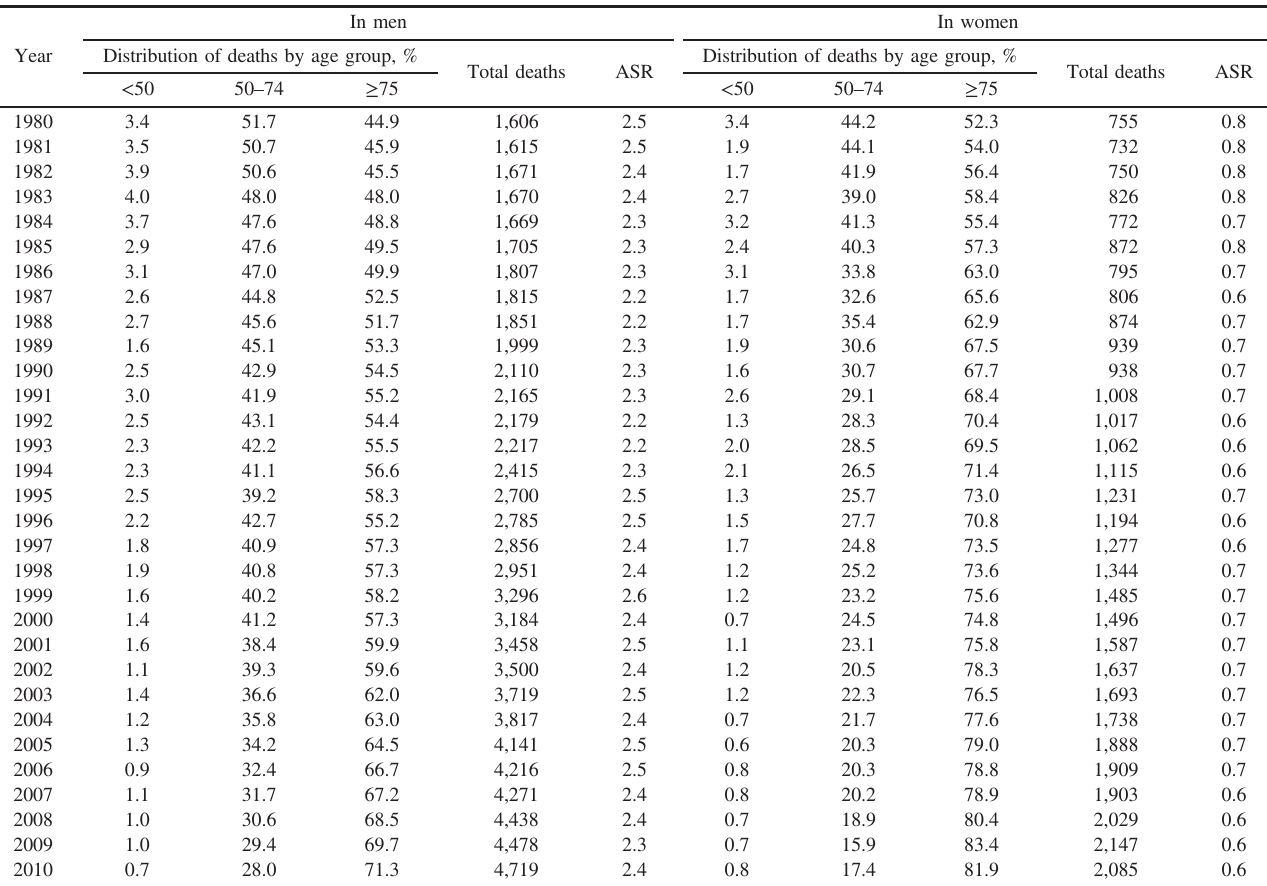
Table 2. Number of deaths, and age-standardized rate (ASR a ) for deaths caused by bladder cancer in Japan, 1980 – 2010 In men In women Year Distribution of deaths by age group, % Total deaths